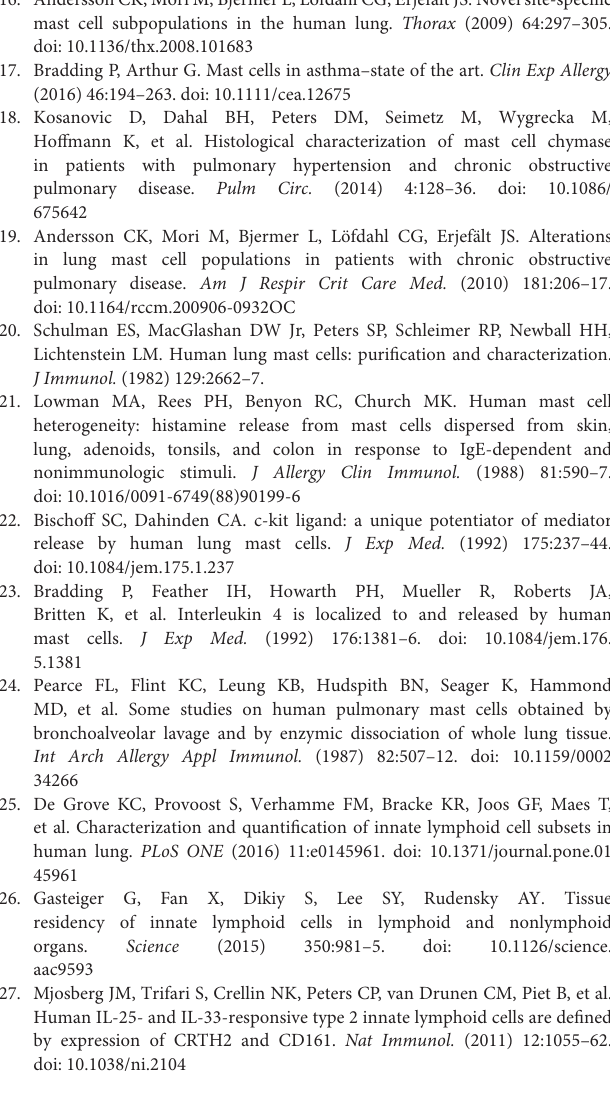
Supplementary Figure 1 | Cells isolated using WEMP protocol. Percentage of viable cells of CD45 + singlet cells gated. Supplementary Video 1 | Mechanical disruption using 50ml syringe. Enzymatically digested human lung tissue pieces mechanically disrupted using 50ml